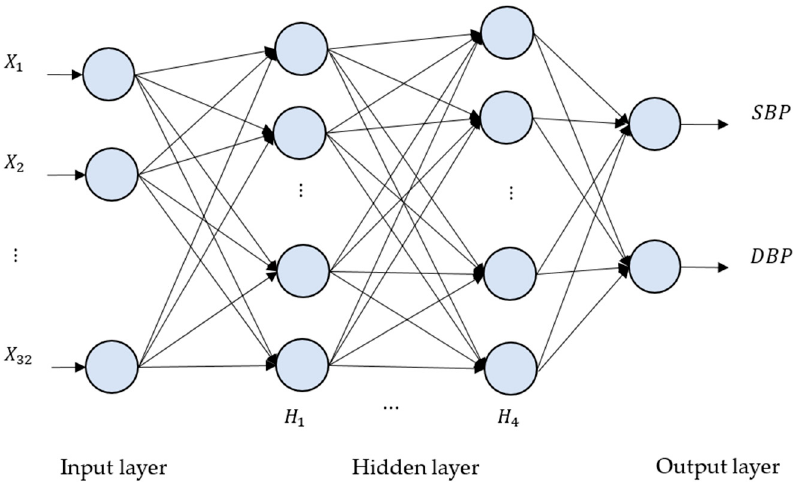
Figure 6. The deep neural network (DNN) architecture for the proposed method. There are four hidden layers, denoted as H1, ... , H4. The numbers of neurons for H1, H2, H3 and H4 are 2048, 4096, 8192 and 2048, respectively.